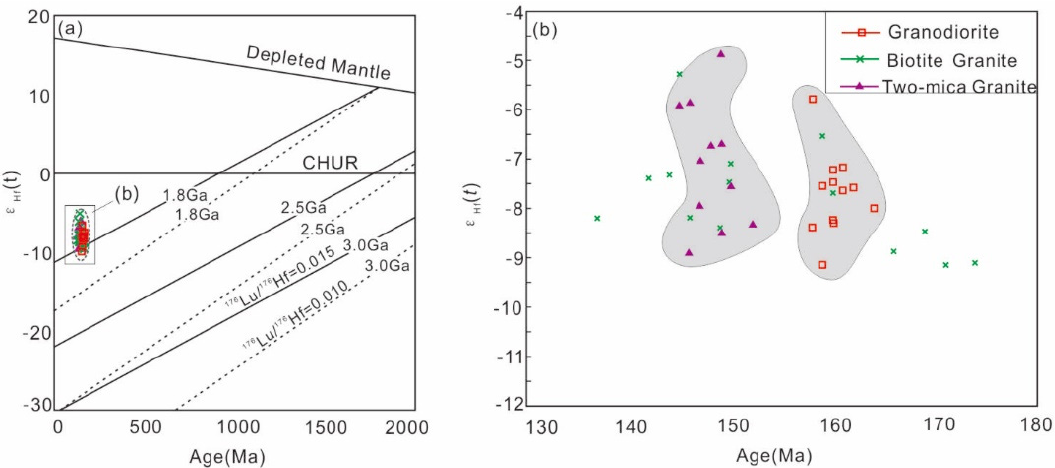
Figure 7. Plot of zircon ε Hf (t) vs. 206 Pb/ 238 U ages ( a ), and variation Hf isotopic trend of the samples ( b ), for Zhuxi granites of the Jingdezhen area, indicating the intrusion formed by the reworking of middle-lower crust. The corresponding lines are after [79]. The shaded area denotes published data for the Zhuxi granites [38,42,43].